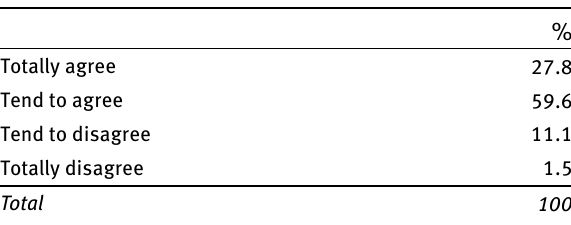
Table 1: The diffusion of robots in society will improve people’s quality of